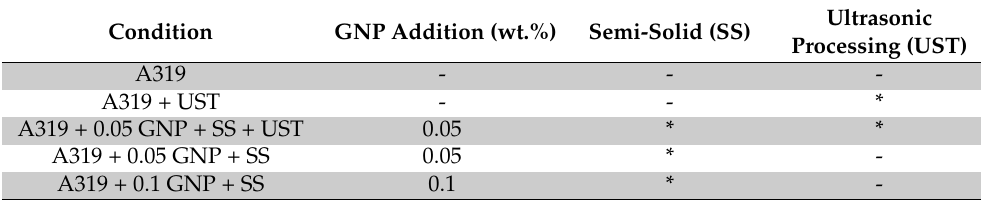
Table 1. Summary of casting conditions and designation.